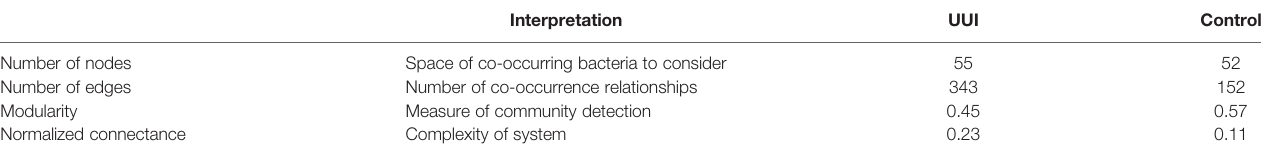
TABLE 3 | Summary of metrics for vaginal microbiome networks.